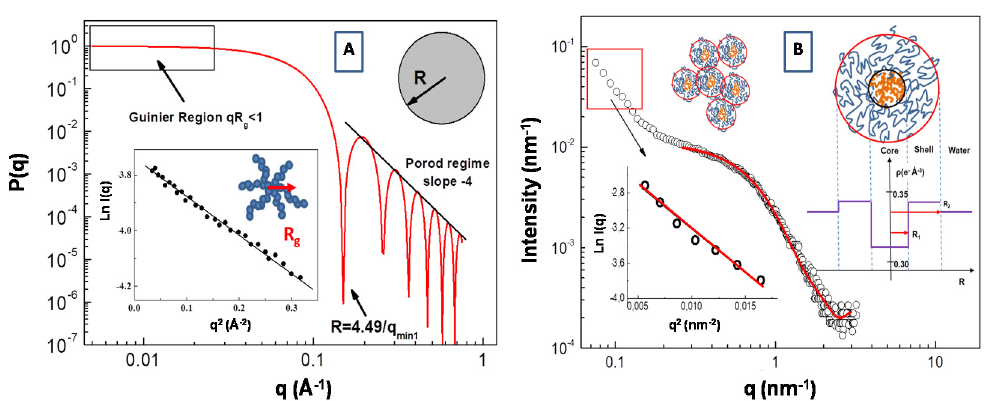
Figure 4. Plot of the form factor P ( q ) of a sphere with R = 30 Å. An example of a SAXS Guinier fitting of P ( q ) of a star polymers nanopartarticle (with a radius of gyration Rg = 17.2 Å) in water solution is presented in the inset ( A ). Fit of the form factor P ( q ) SAXS intensity for the polydimethylsiloxane-b-polyethyleneoxide (PDMS-b-PEO)/water. System (at ca oncentration of 0.05 g/cm 3 ) with the core-shell model ( B ). Scattering-length density (SLD) distribution of the core-shell micelles is reported in the inset (adapted from Lombardo et al. [61]).